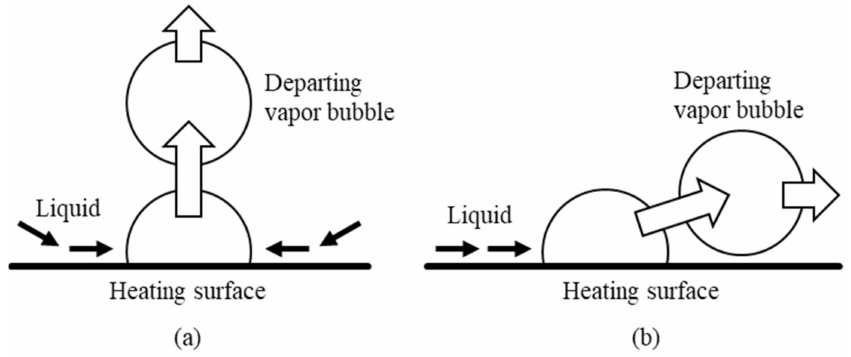
Figure 6. Type of bubble separation. ( a ) Normal to the surface ( b ) Along the